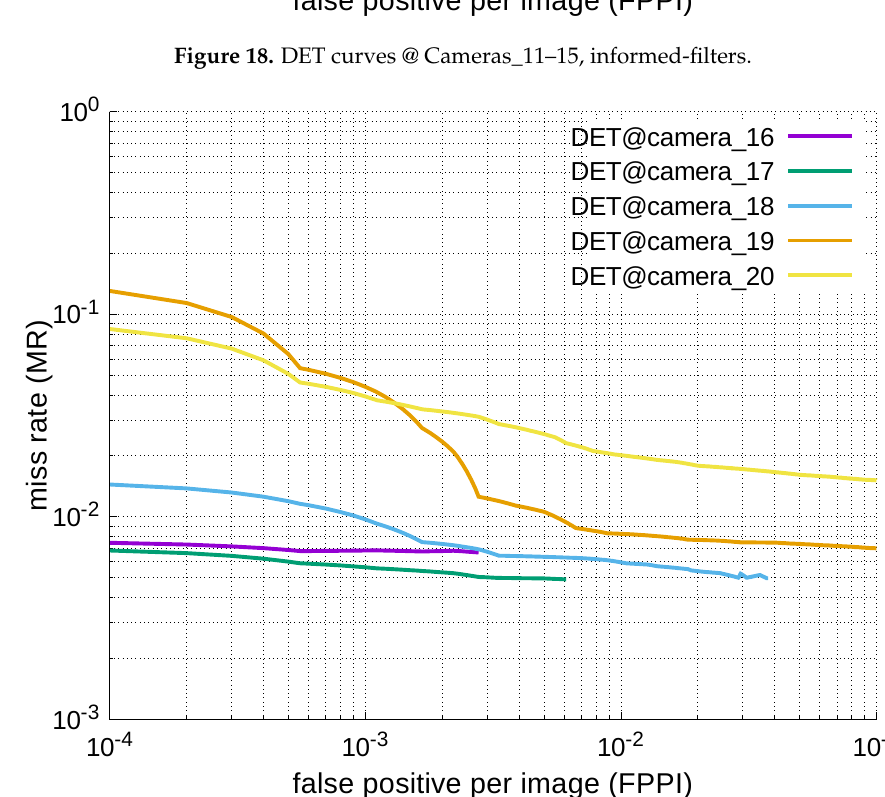
Figure 19. DET curves @ Cameras_16–20,